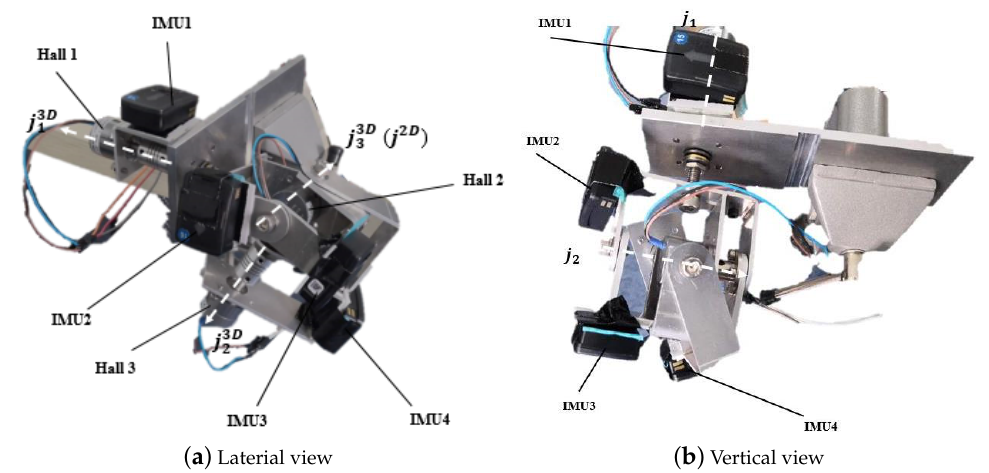
Figure 3. Laterial and vertical views of the 3-DoF